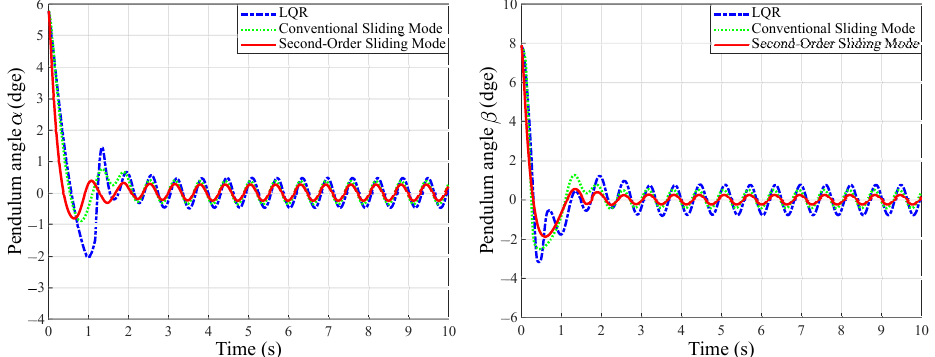
Figure 14. The simulation results with the disturbance compare the angle responses of the inverted pendulum on α and β , respectively.